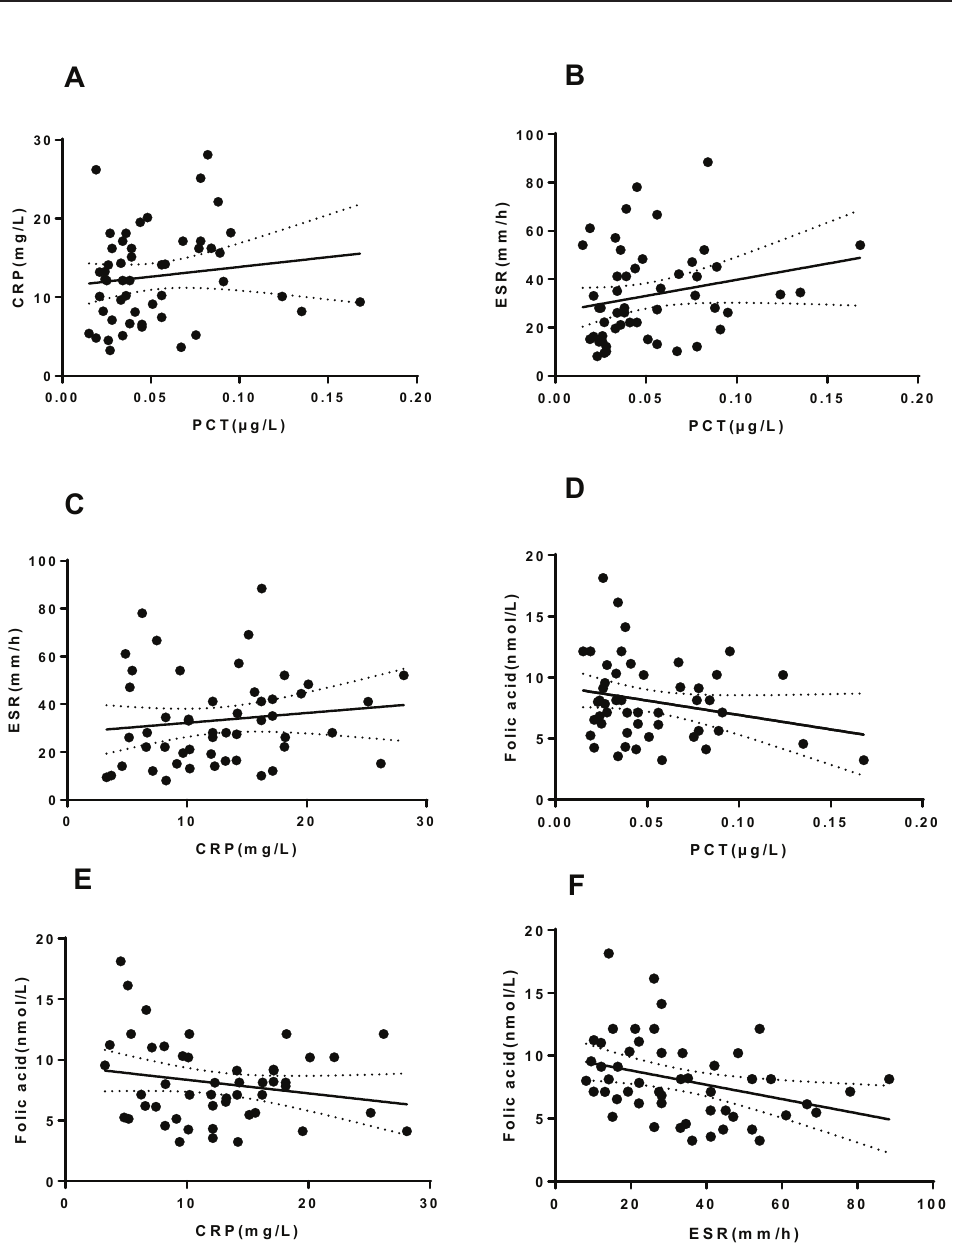
Figure 4: Scatter plot of Pearson correlation test among serum CRP, ESR and PCT (A: CRP vs PCT; B: ESR vs PCT; C: ESR vs CRP; D:Folic acid vs PCT; E: Folic acid vs CRP; F: Folic acid vs